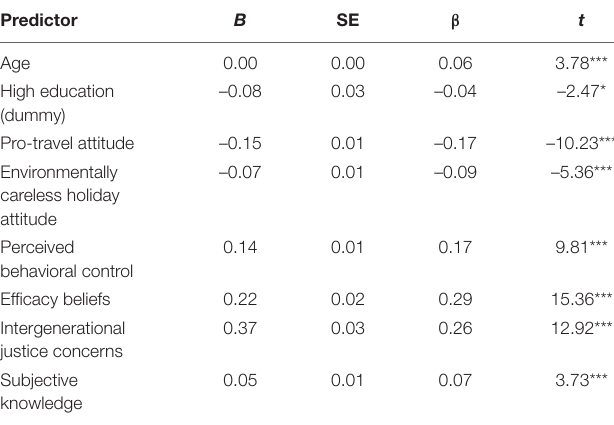
TABLE 7 | Results of linear multiple regression of policy support to reduce flights.